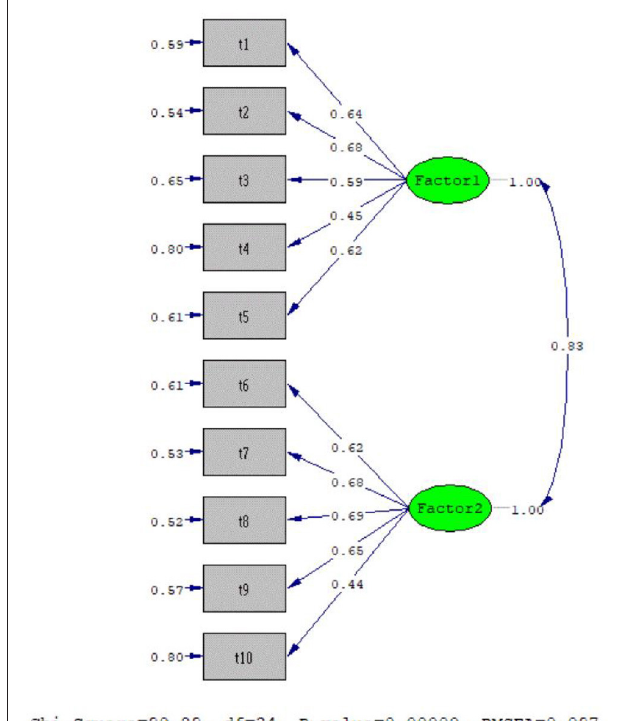
FIGURE 9 | Confirmatory factor analysis